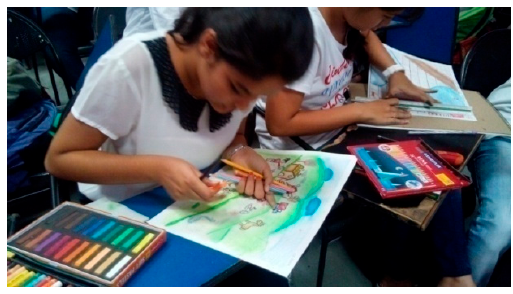
Figure 7. Children’s aspirations workshop.